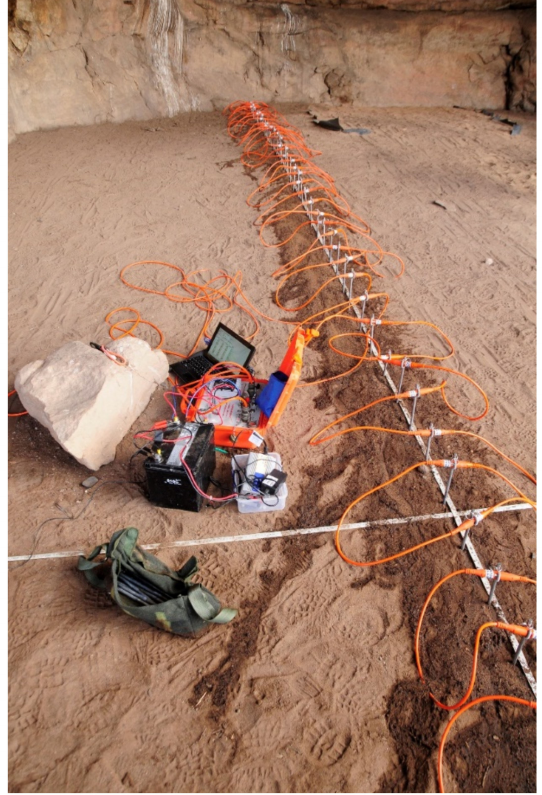
Figure 2. ZZ FlashRes64 ERT system being used in the field. Note the wetness around the electrodes from where they were watered to lower the contact resistance.